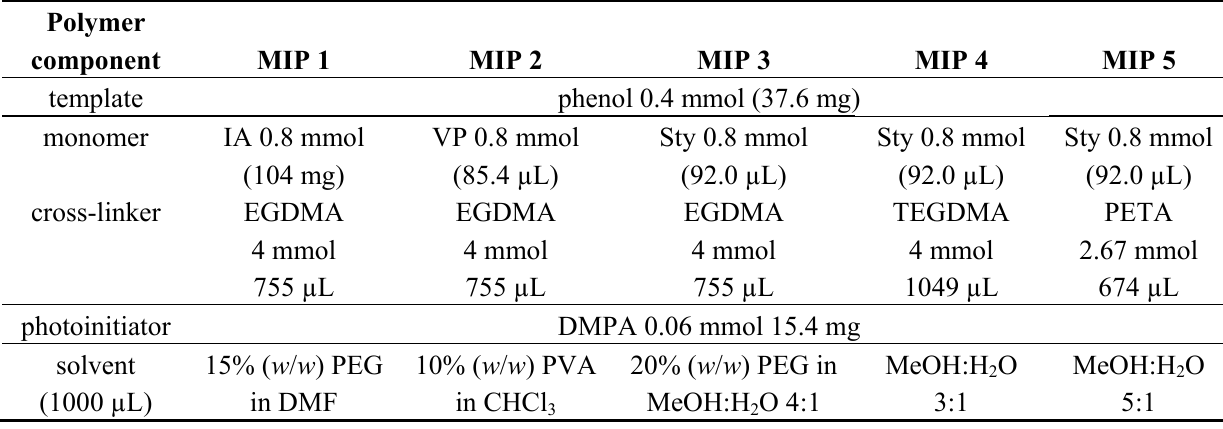
Table 4. Composition of MIP prepolymerization